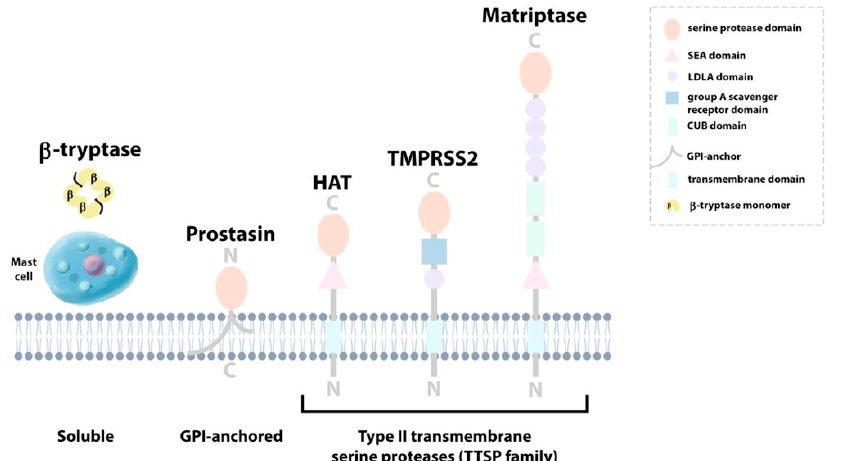
Figure 1. Airway trypsin-like proteases (TLPs). β -tryptase is released from mast cells in the airway epithelium in its active heterotrimeric form. Prostasin is a glycophosphatidylinositol (GPI)-anchored protein that contains a serine protease catalytic domain. The type II transmembrane serine proteases (TTSPs) are illustrated with their conserved serine protease domain linked to their respective extracellular domains ( SEA , sea urchin sperm protein, enterokinase and agrin; LDLA, low-density lipoprotein receptor A; group A scavenger receptor; CUB C1s/C1r, urchin embryonic growth factor and bone morphogenetic protein-1) and transmembrane domains. Amino and carboxy termini are indicated by N and C, respectively.